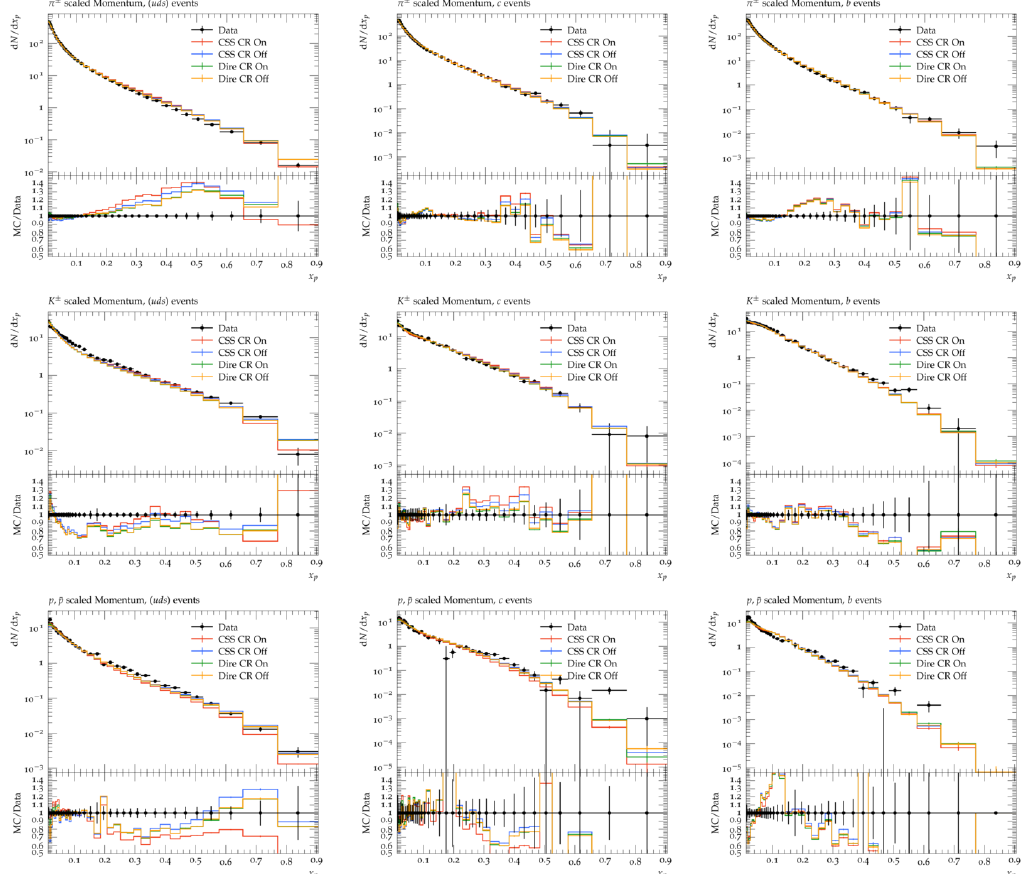
Figure 9: Production of π ± (upper row), K ± (middle row) and p (lower row) in uds (left column), c (middle column), and b (right column) events. All distributions are compared with data from S LD [ 63 ] .